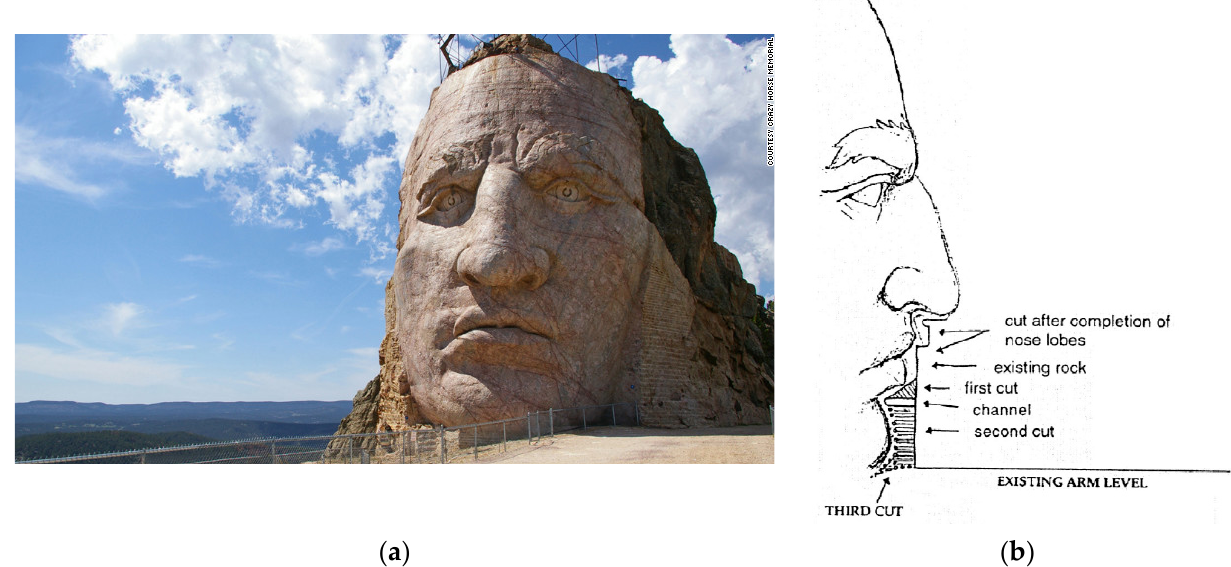
Figure 1. ( a ) the Crazy Horse Memorial, a Native American monument, carved with explosives in the granite of the Black Hills, South Dakota [1]. ( b ) dimensions of the face of the “Crazy Horse” sculpture, and detail of the execution phases of the profile’s roughing by explosives. Whole face: height 26.7 m, width 17.7 m; forehead: height 9.7 m; eyebrows: height 6 m, width 2.3 m; eye opening: height 2.4 m, width 1 m; nose: height 8.2 m, width 5.2 m; lips: max height 1.8 m, max width 5.8 m [2].